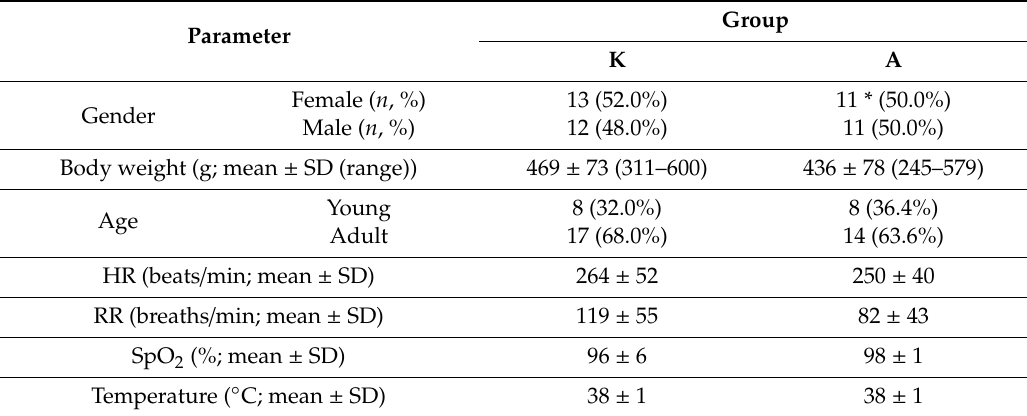
Table 2. Demographic characteristics and baseline physiologic parameters of wild gray squirrels undergoing gonadectomy and receiving either ketamine-dexmedetomidine-midazolam (group K, n = 25) or alfaxalone-dexmedetomidine-midazolam (group A; n = 22) intramuscularly